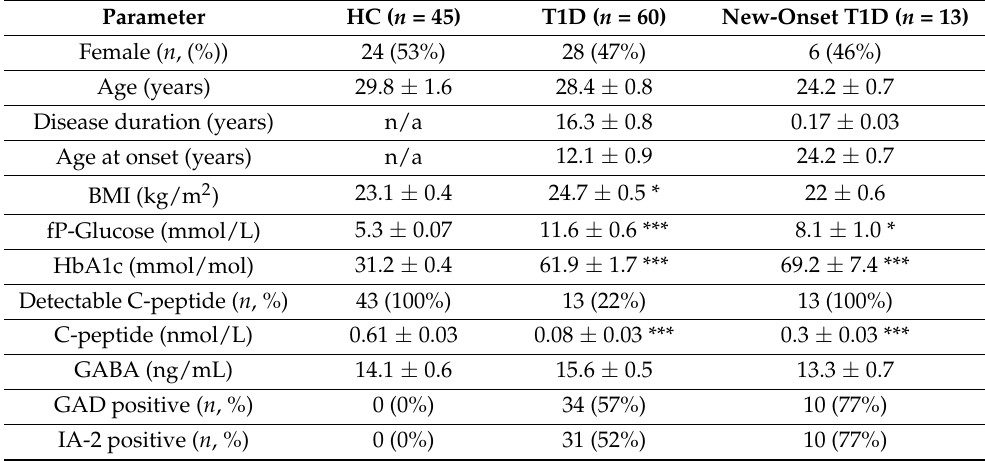
Table 1. Descriptive data of healthy controls and patients with type 1